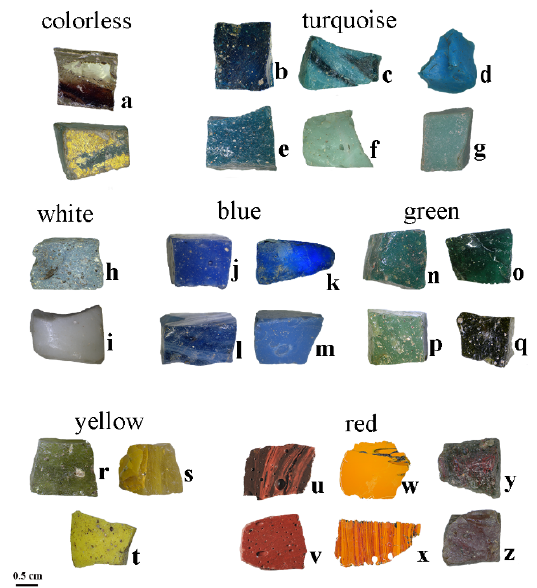
Figure 1. OM images of a selection of glass tesserae, illustrating all the colors and textures present in the assemblage investigated here: ( a ) PN AU2; ( b ) PN BS1; ( c ) PN TU2; ( d ) PN TU3; ( e ) PN